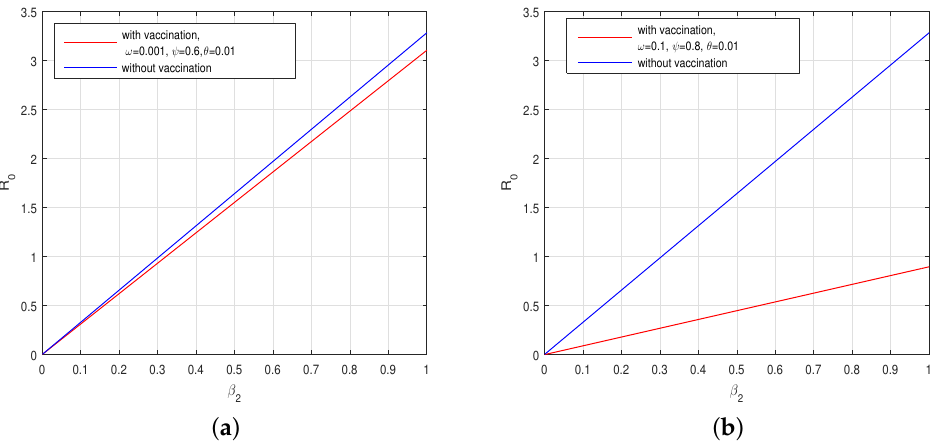
Figure 10. Comparison of the basic reproduction for various values of ω , ψ , and θ for with and without vaccine cases. Subfigures ( a , b ) describe the comparison of the basic reproduction numbers for various values of ω = 0.01, ψ = 0.6, θ = 0.01 and ω = 0.1, ψ = 0.8, θ = 0.01,